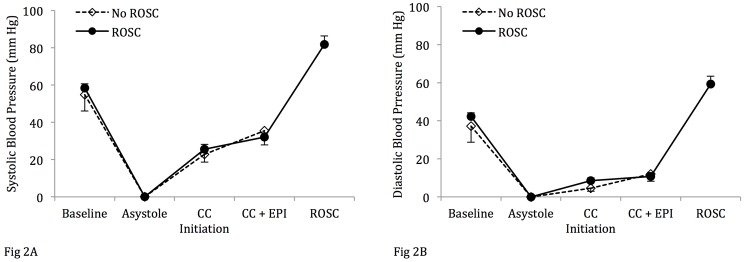
Arterial blood pressures during study period.There is no difference in mean systolic blood pressures (A) and mean diastolic blood pressures (B) between lambs that achieve return of spontaneous circulation (ROSC) and those with no ROSC. Epinephrine did not statistically increase blood pressures in either group. Data are mean ± SEM bars.